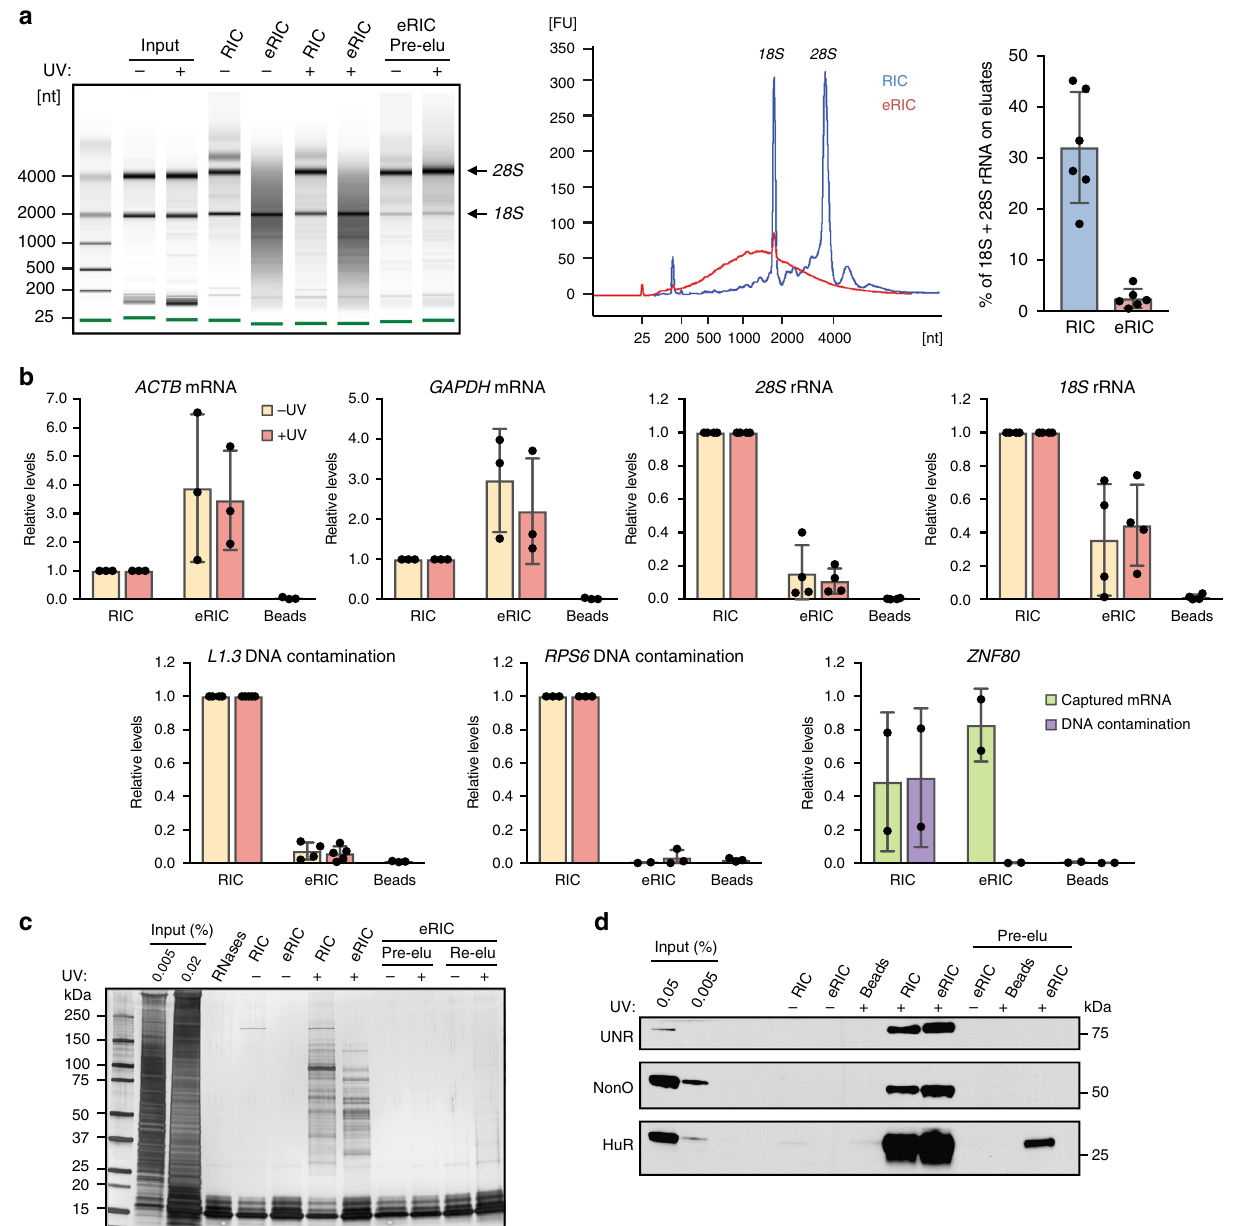
Fig. 2 eRIC captures polyadenylated RNA and covalently crosslinked proteins with high speci fi city. a , b Nucleic acids isolated by eRIC, RIC, or using uncoupled beads along the eRIC protocol on irradiated material ( “ Beads ” ) were analyzed using a 6000 Pico bioanalyzer ( a ) or by RT-qPCR ( b ). Note that the pre-elution step ( “ Pre-elu ” ) incorporated in eRIC leads to an effective removal of rRNAs, specially the 28S rRNA, without compromising the capture of poly(A) RNAs. a Representative result are shown in the left and middle panels; data on the right panel correspond to mean and standard deviation (s.d.) from six biologically independent experiments. − UV non-irradiated controls, + UV irradiated samples, [nt] length of RNA in number of nucleotides, [FU] fl uorescence units. b Data correspond to mean and s.d. from at least three biologically independent experiments except for ZNF80 (two experiments). c , d Isolated proteins were separated by SDS-PAGE and silver-stained ( c ) or analyzed by western blot with antibodies to the positive control RBPs UNR, NonO, and HuR ( d ). The lane “ RNases ” contains a dilution of RNases A and T1. Note that lower bands in silver staining correspond to these enzymes. Re-elu heat elution performed after RNAse treatment. Note that a minor fraction of HuR appears to be associated with non-polyadenylated RNAs